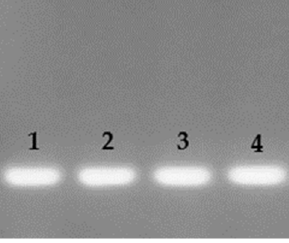
Figure 7. SDS-polyacrylamide gel electrophoresis of h CA-I and h CA-II purified by Se-pharose-4B-L-tyrosine-sulfanilamide affinity gel chromatography (Lanes 1 and 2 are for h CA-I; and Lanes 3 and 4 are for h CA-II). Table 3. Affinity chromatography purification scheme for the human erythrocyte carbonic anhy- drase-I and -II isoenzymes.